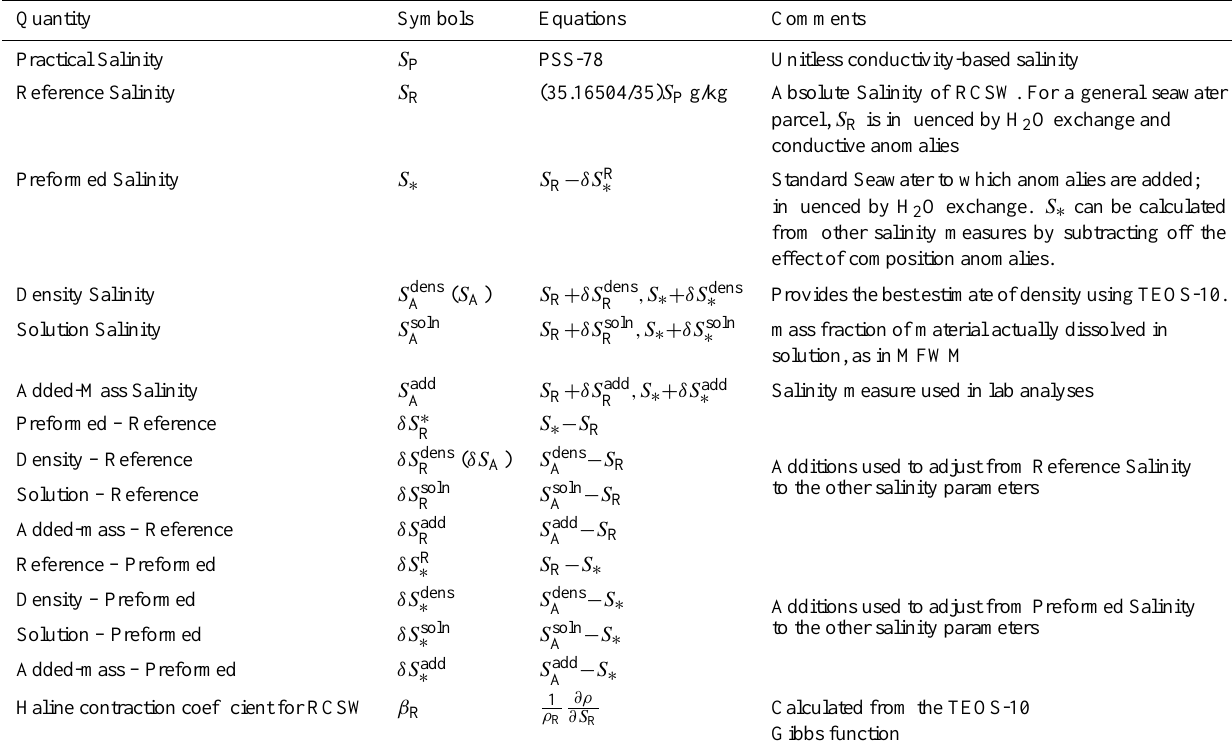
Table A1. The various salinity variables and the relations between them. Quantity Symbols Equations Comments Practical Salinity S P PSS-78 Unitless conductivity-based salinity Reference Salinity S R (35.16504/35) S P g/kg Absolute Salinity of RCSW. For a general seawater Preformed Salinity S ∗ S R − δS R ∗ Standard Seawater to which anomalies are added;